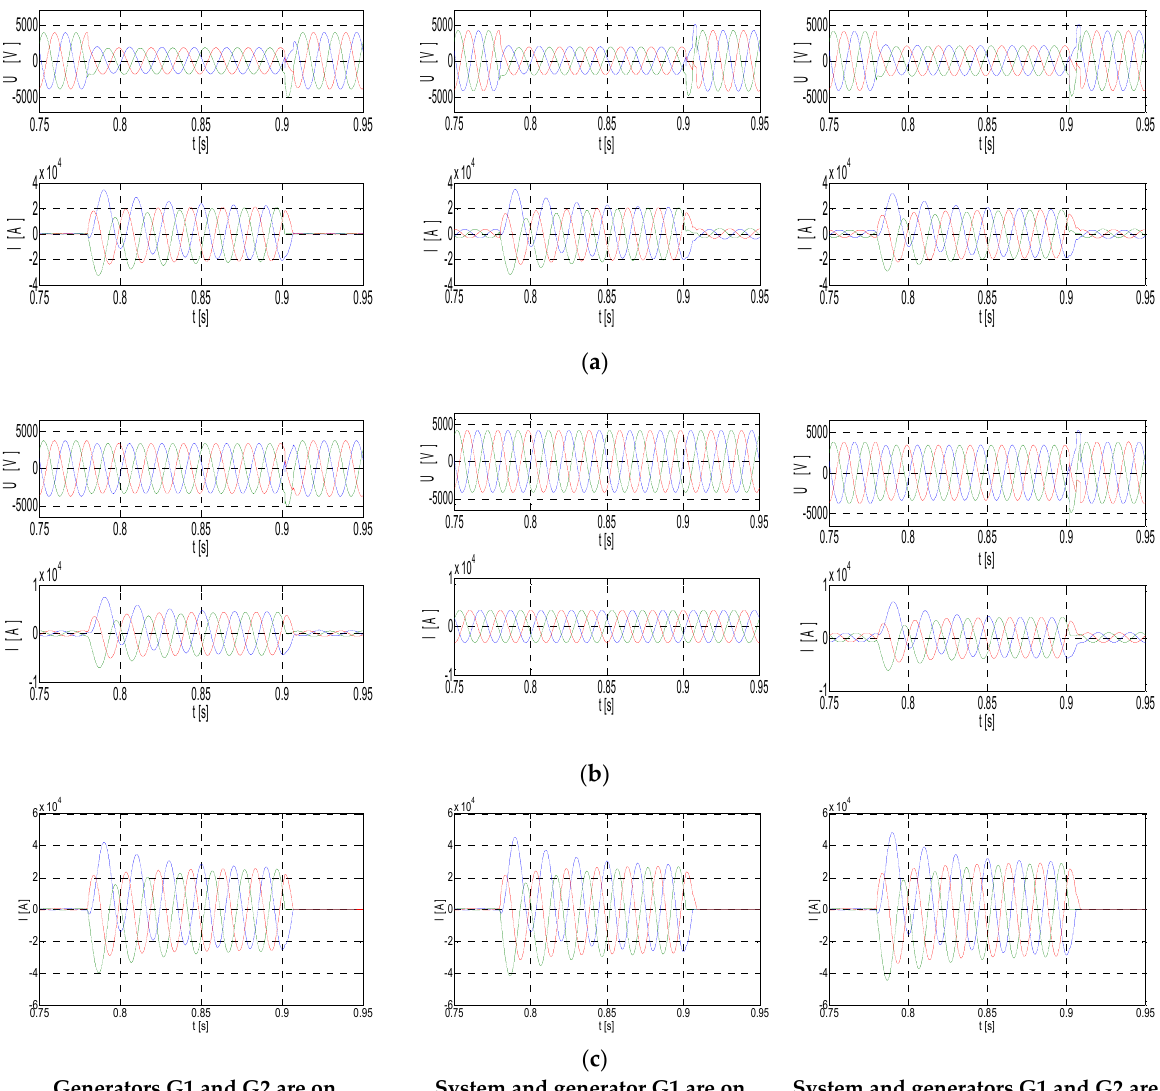
System and generators G1 and G2 are on Figure 6. The transients in the grid components (phase A - blue, phase B - green, phase C - red): ( a ) Bus phase voltages and currents of synchronous generator G1; ( b ) Bus phase voltages and currents of synchronous generator G2; ( c ) Currents of the reactor SR2.